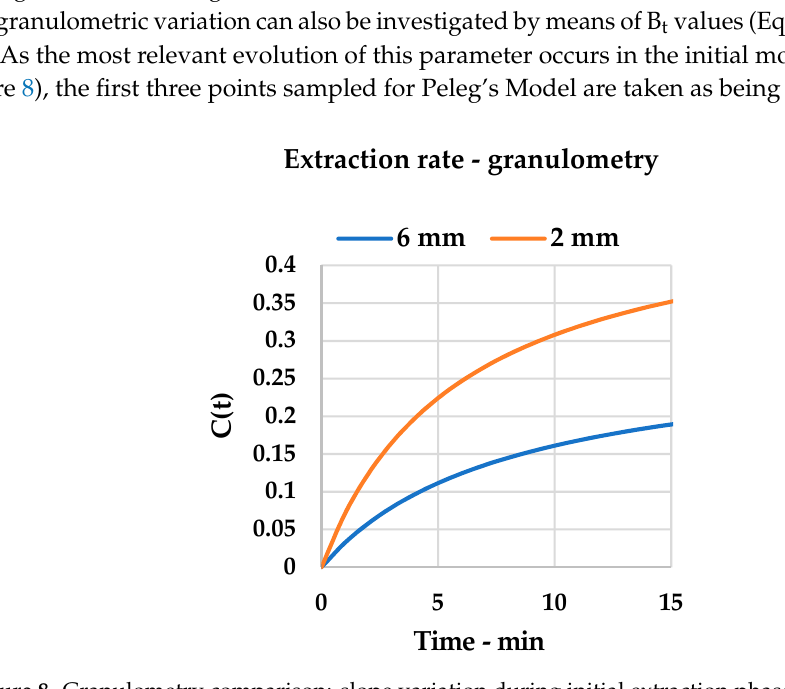
Figure 8. Granulometry comparison: slope variation during initial extraction phase, Peleg model.